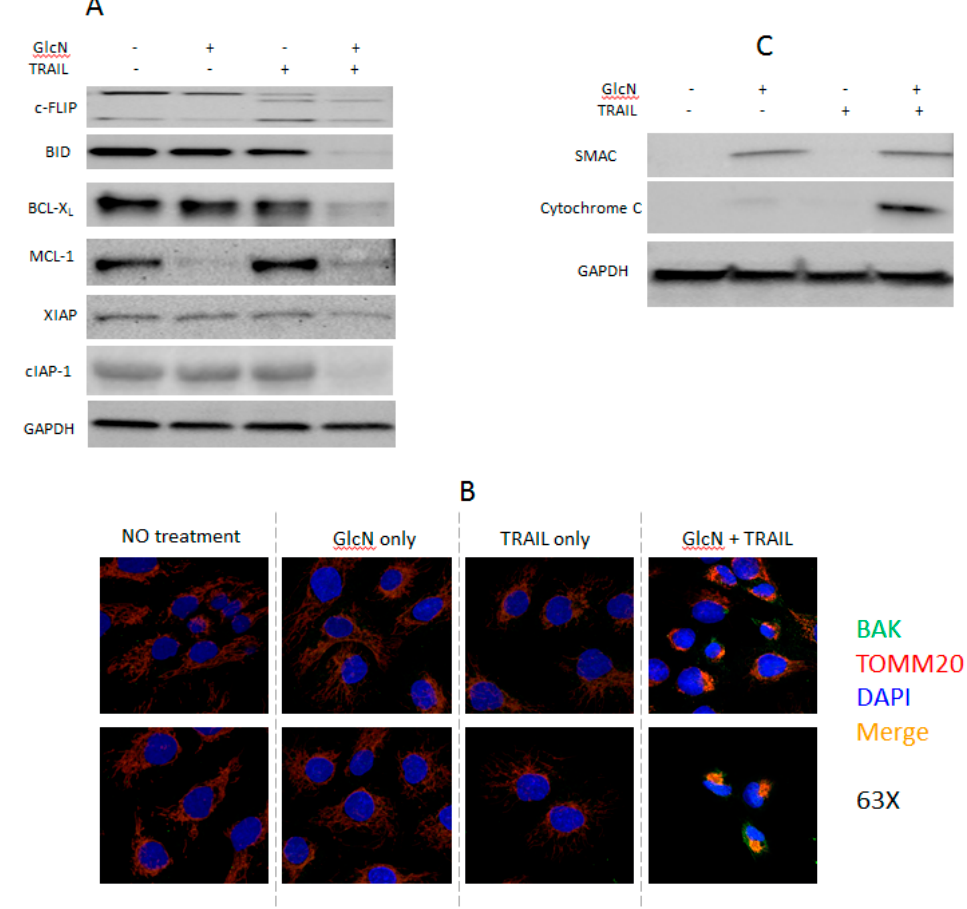
Figure 2. GlcN / TRAIL treatment in DU145 cells modulates both extrinsic and intrinsic apoptotic regulators. ( A ) Cells were treated as in Figure 1C and whole-cell extracts were prepared and analyzed by immunoblotting with antibodies against c-FLIP, BID, BCL-XL, MCL-1, XIAP, cIAP-1 and GAPDH. ( B ) Confocal imaging of DU145 cells treated the same as in A and stained with BAK (green), TOMM20 (red) and DAPI (blue), magnification 63 × . ( C ) Cells were treated as described in A and cytosolic extracts were probed with antibodies against SMAC, cytochrome C and GAPDH.